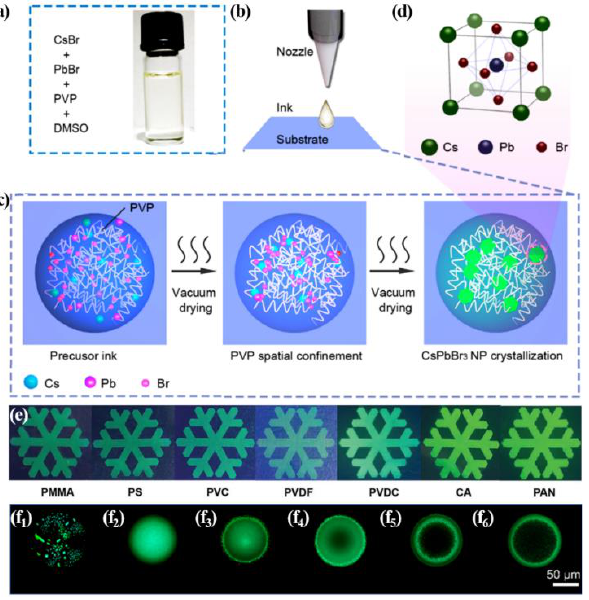
Figure 4. ( a ) CsPbBr 3 /PVP/DMSO solution for inkjet printing ( b ) the process of inkjet printing: the moment the CsPbBr 3 /PVP/DMSO solution comes out from nozzle ( c ) schematic diagram of the evaporation and crystallization after dropping ink. ( d ) final lattice structure of CsPbBr 3